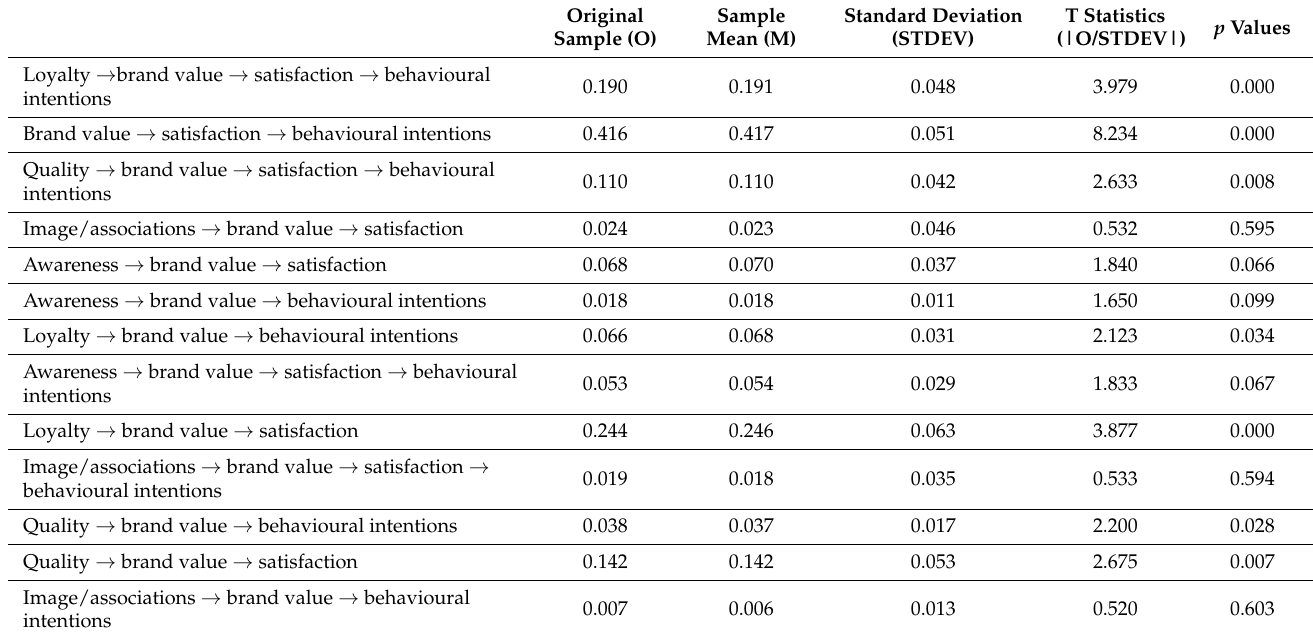
Table 7. Specific indirect